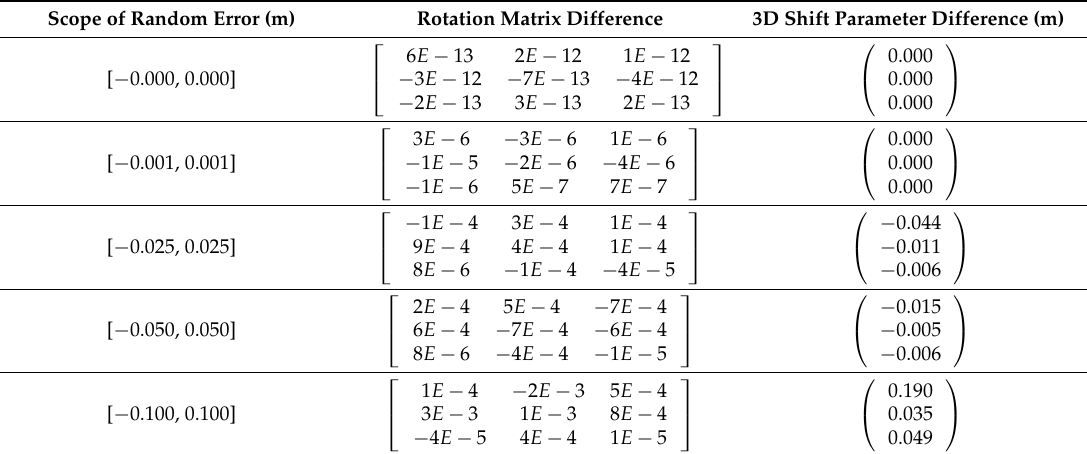
Table 6. Rotation and shift parameters difference after random error